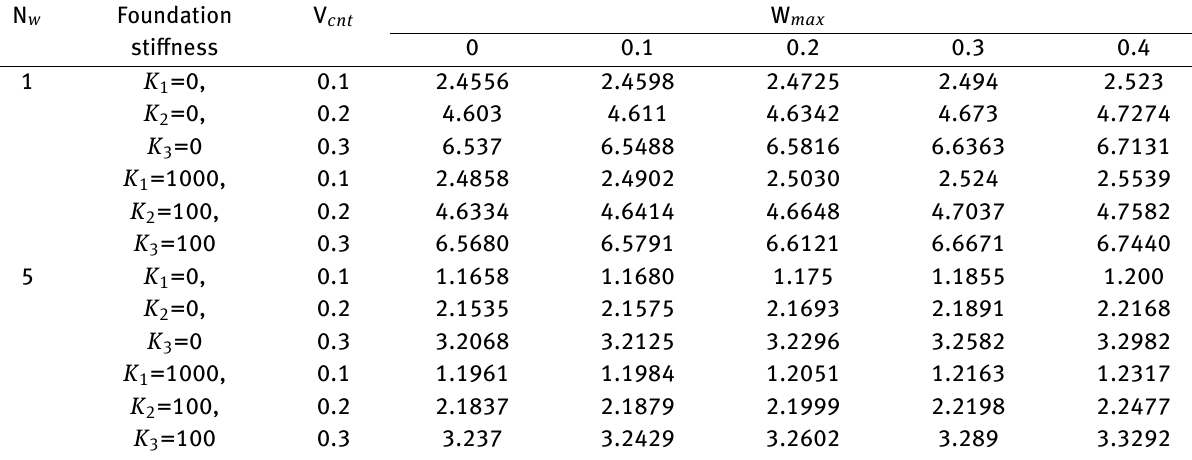
Table 4: Nonlinear performance of MWCNTRCB with CNT volume fraction N w